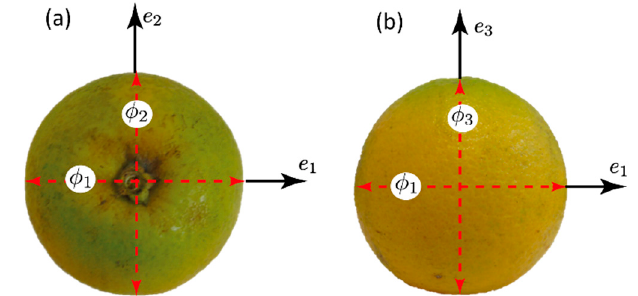
Figure 3. Orthogonal diameters defined on the Valencia orange (semi-ripe image). ( a ) Plane e 1 − e 2 . ( b ) Plane e 1 − e 3 .